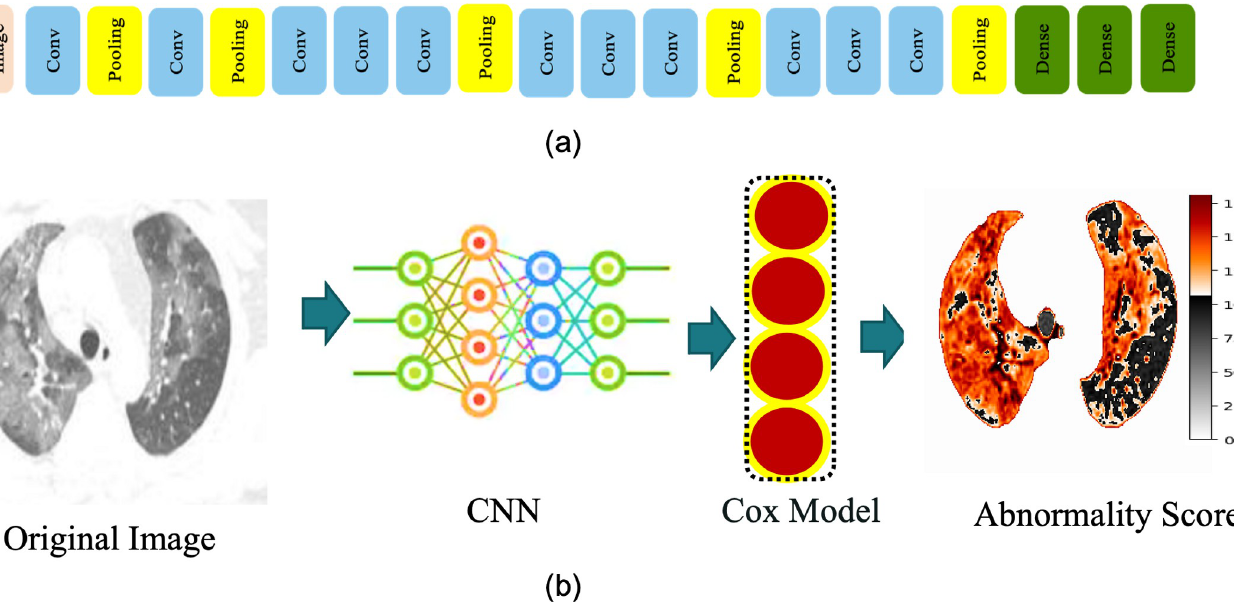
PLOS ONE | https://doi.org/10.1371/journal.pone.0263916 March 14,